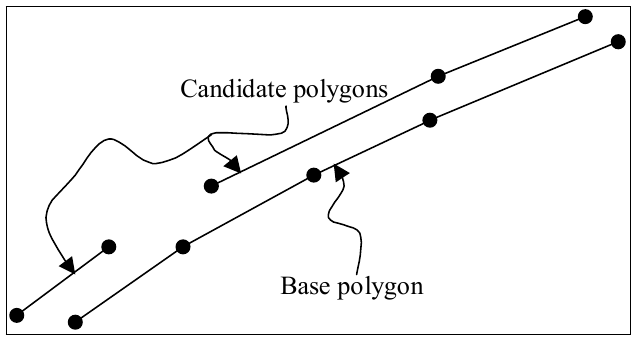
Fig. 6 – Examples of possible combinations between the base and candidate polygons.